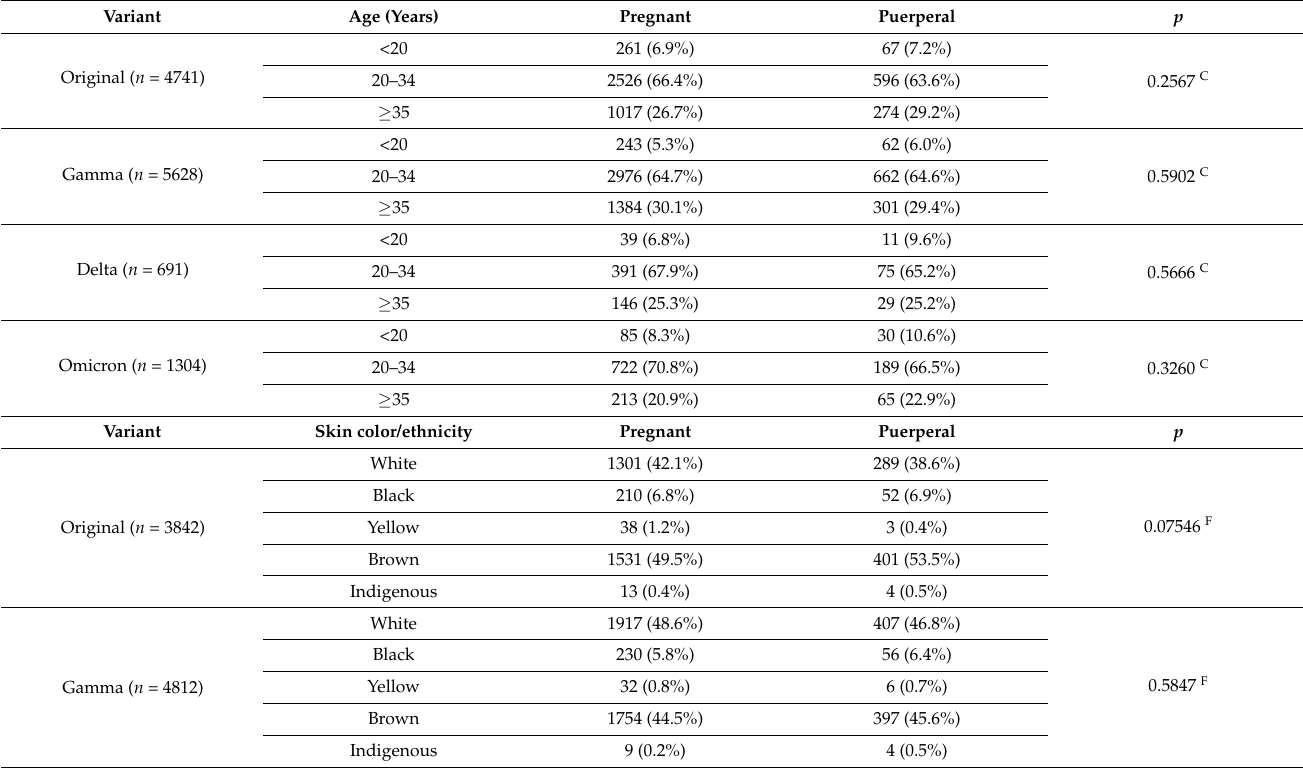
Table 1. Patient